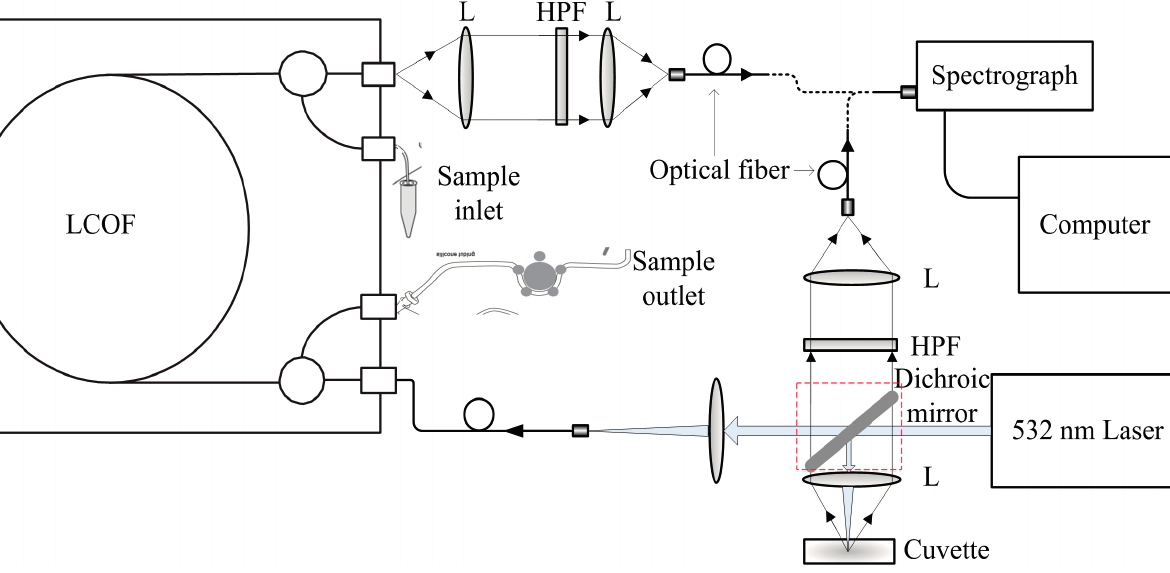
Figure 1. Schematic diagram of the LCOF-Raman experimental setup (R, dichroic mirror; L, optical lens; HPF, high pass